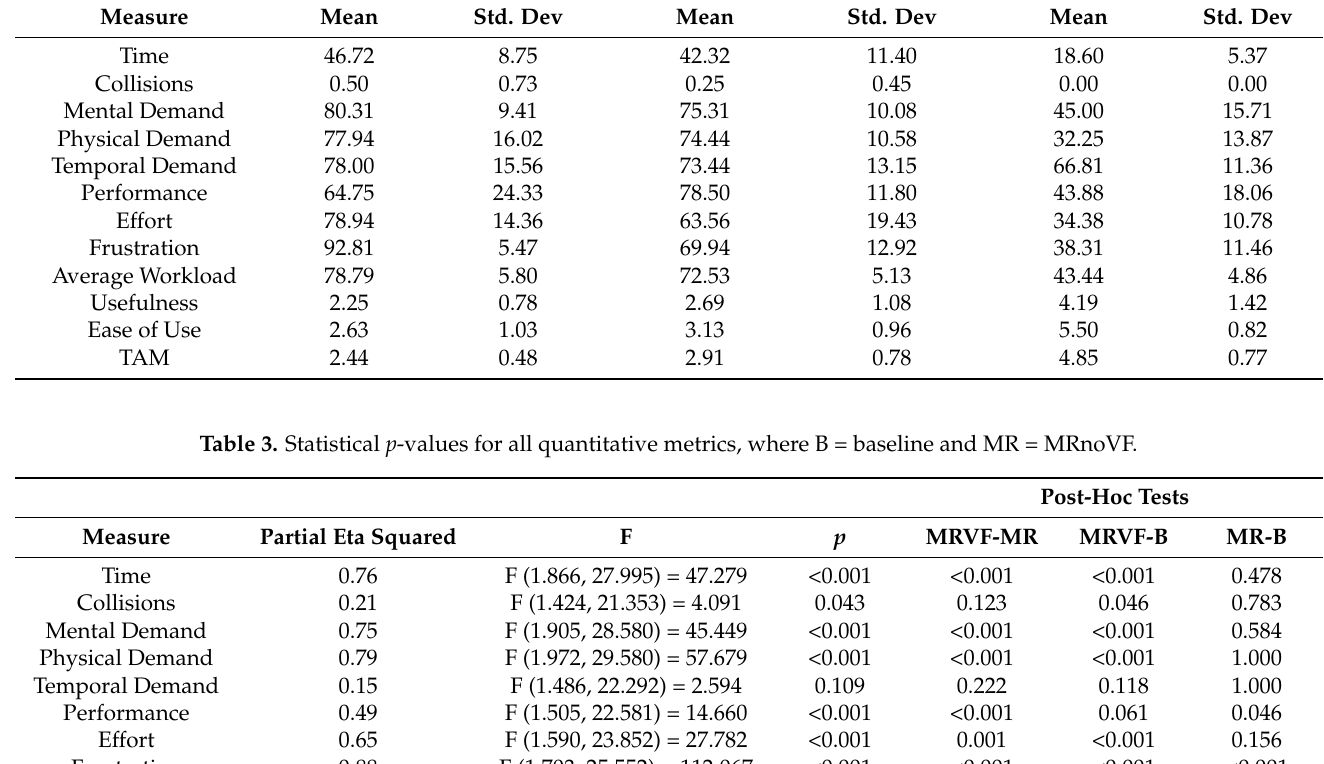
Table 2. Mean values and standard deviations of all objective and subjective measurements. Baseline